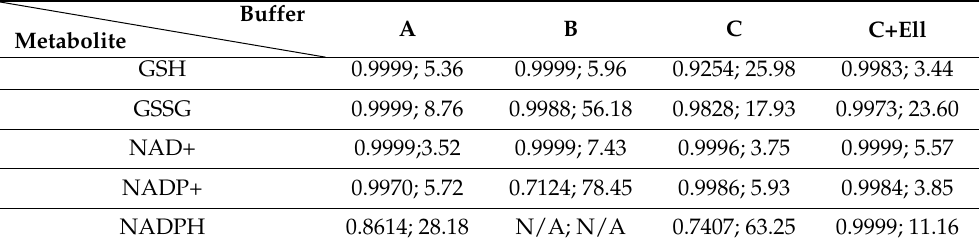
Table 4. Linearity and reproducibility for four buffer comparisons. R squared (R 2 ) values were calculated based on linearity of fit between relative change and cell count. Coefficient of variation (CV) was calculated considering the variability between two biological replicates for three cell counts. Values in cells represent [R 2 ;